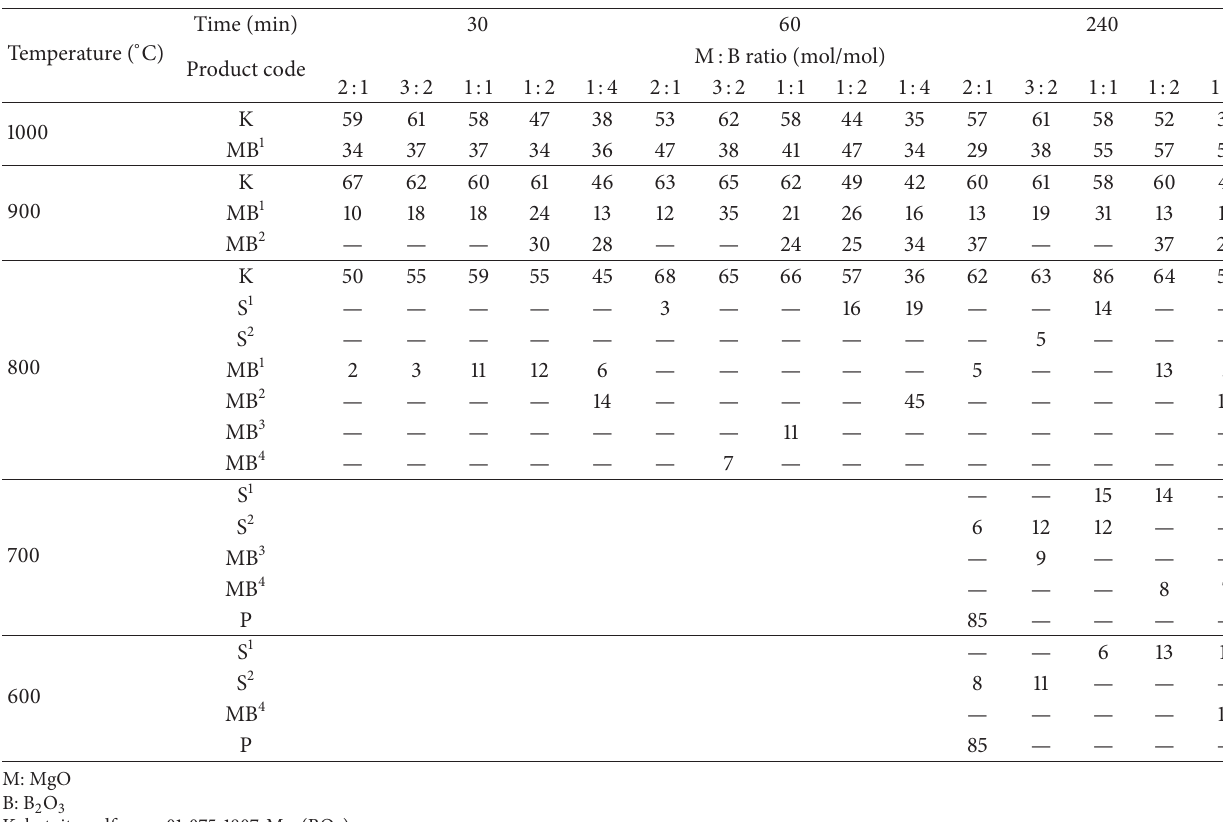
Table 1: XRD crystal scores of the dehydrated magnesium borates produced by solid-state method. Temperature ( ∘ C)